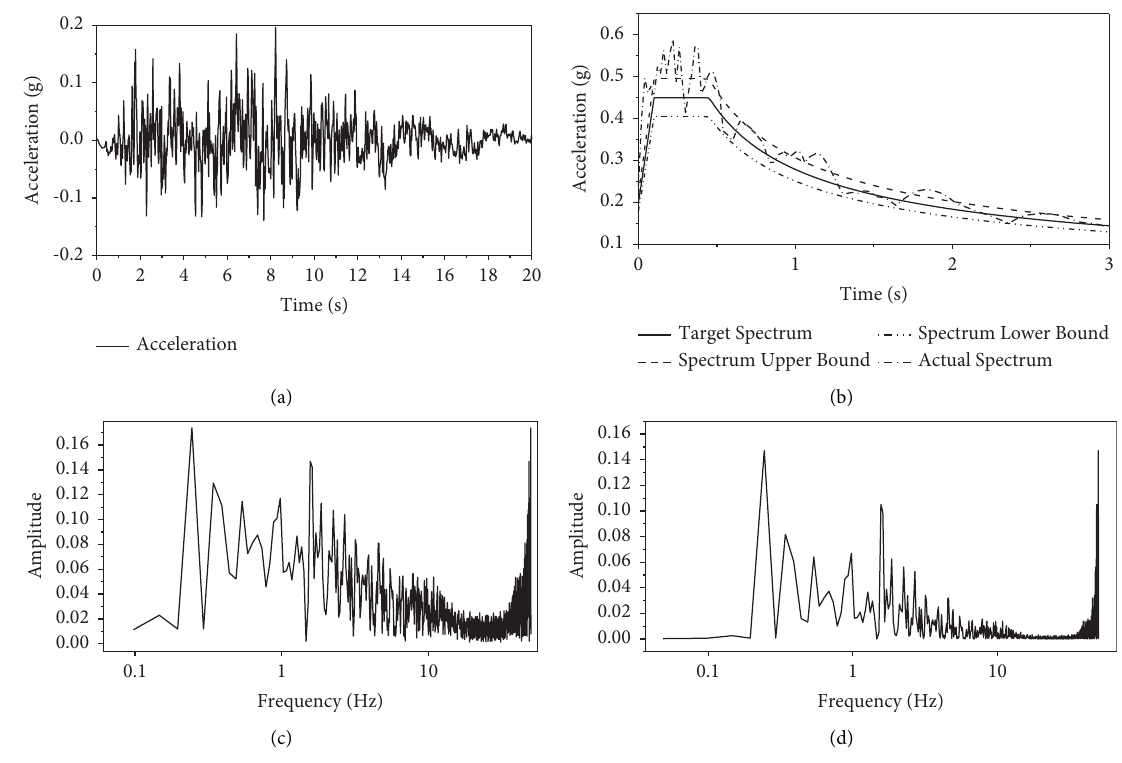
Figure 8: Acceleration time history curve of synthetic seismic wave. (a) Acceleration time history curve. (b) Comparison of seismic wave response spectrum and design reaction spectrum. (c) Seismic wave Fourier spectrum. (d) Seismic wave power